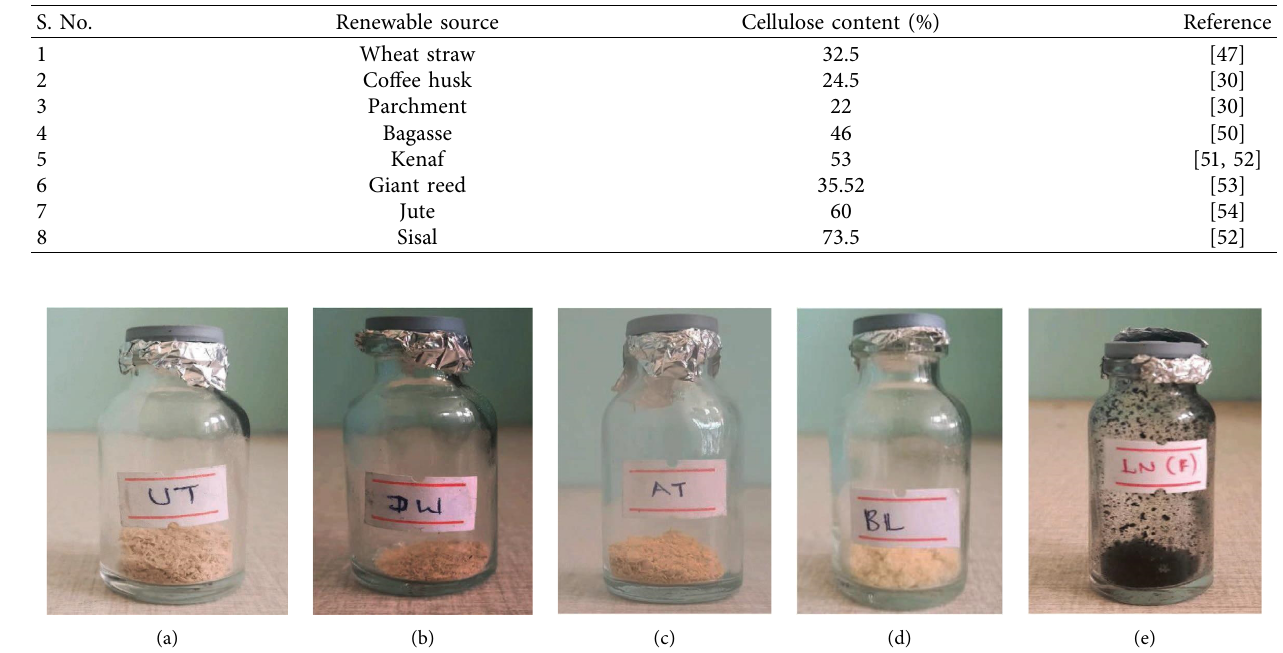
Figure 3: (a) Untreated sample. (b) Extractive free sample. (c) Alkali-treated sample. (d) Bleached sample. (e) Acid-treated sample (to determine the lignin content).